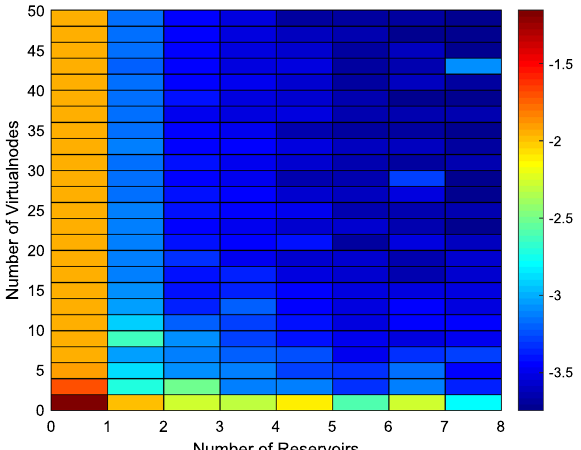
Fig. 5 Influence on synchronizing performance based on different number of time-delay reservoirs and virtual nodes in each